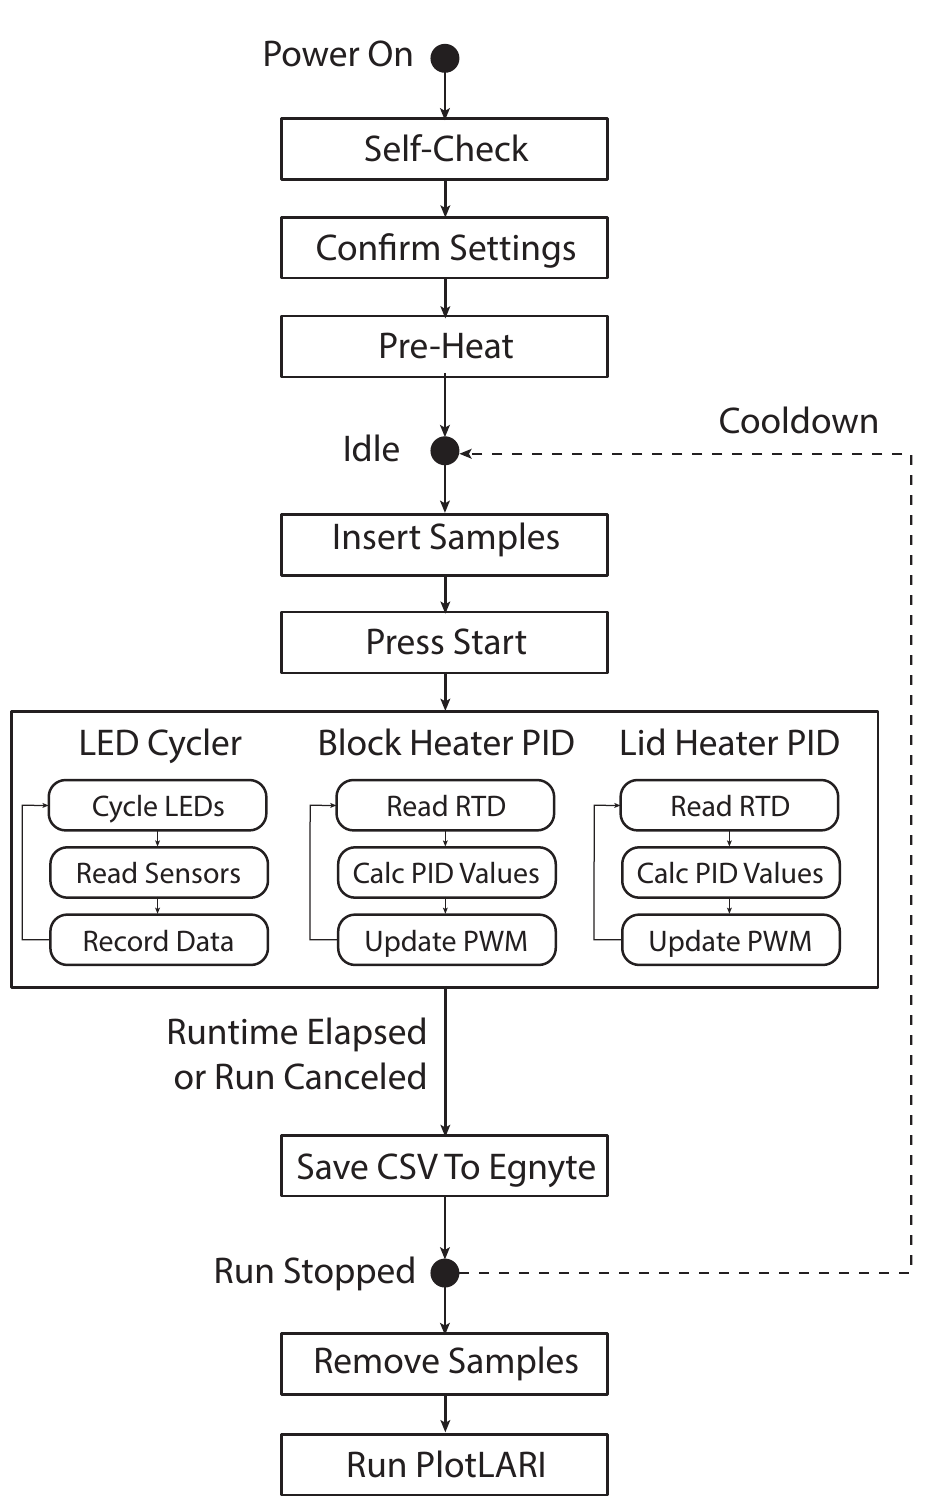
Fig 3. LARI user workflow. Typical steps for performing a LARI